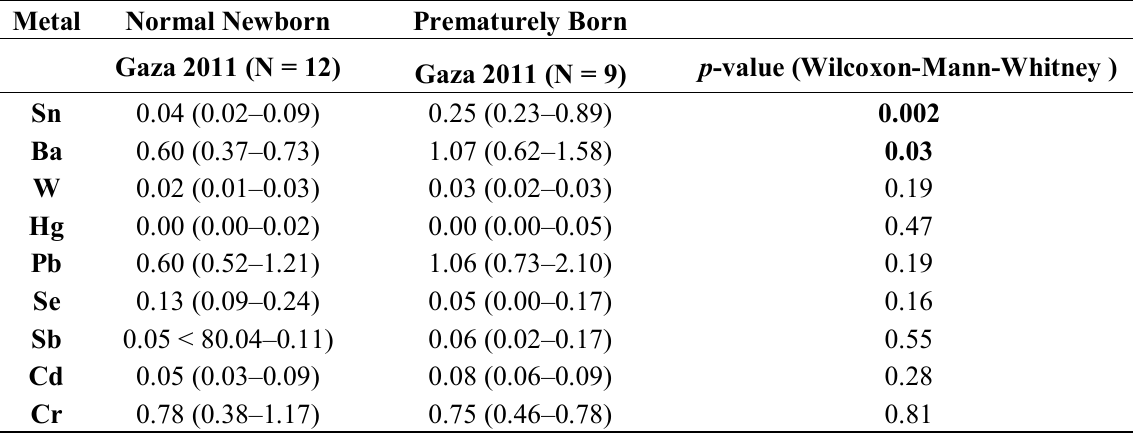
Table 4. Comparison of metal load (ppm) between children prematurely born and